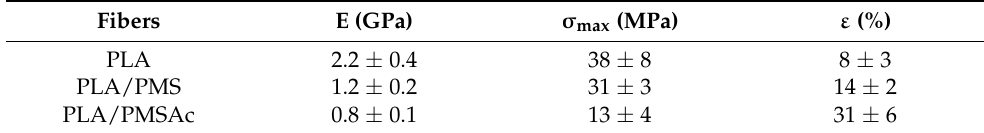
Figure 7. Stress–staincurves of the electrospunfibers of PLA, PLA/PMS, and PLA/PMSAcat 10 mm/min. Table 2. Mechanical parameters obtained from the different